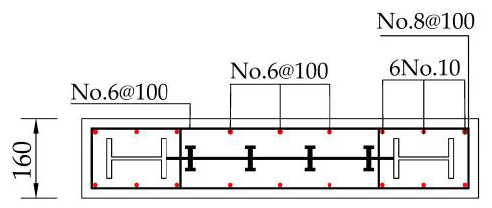
Figure 6. Reinforcement arrangement.